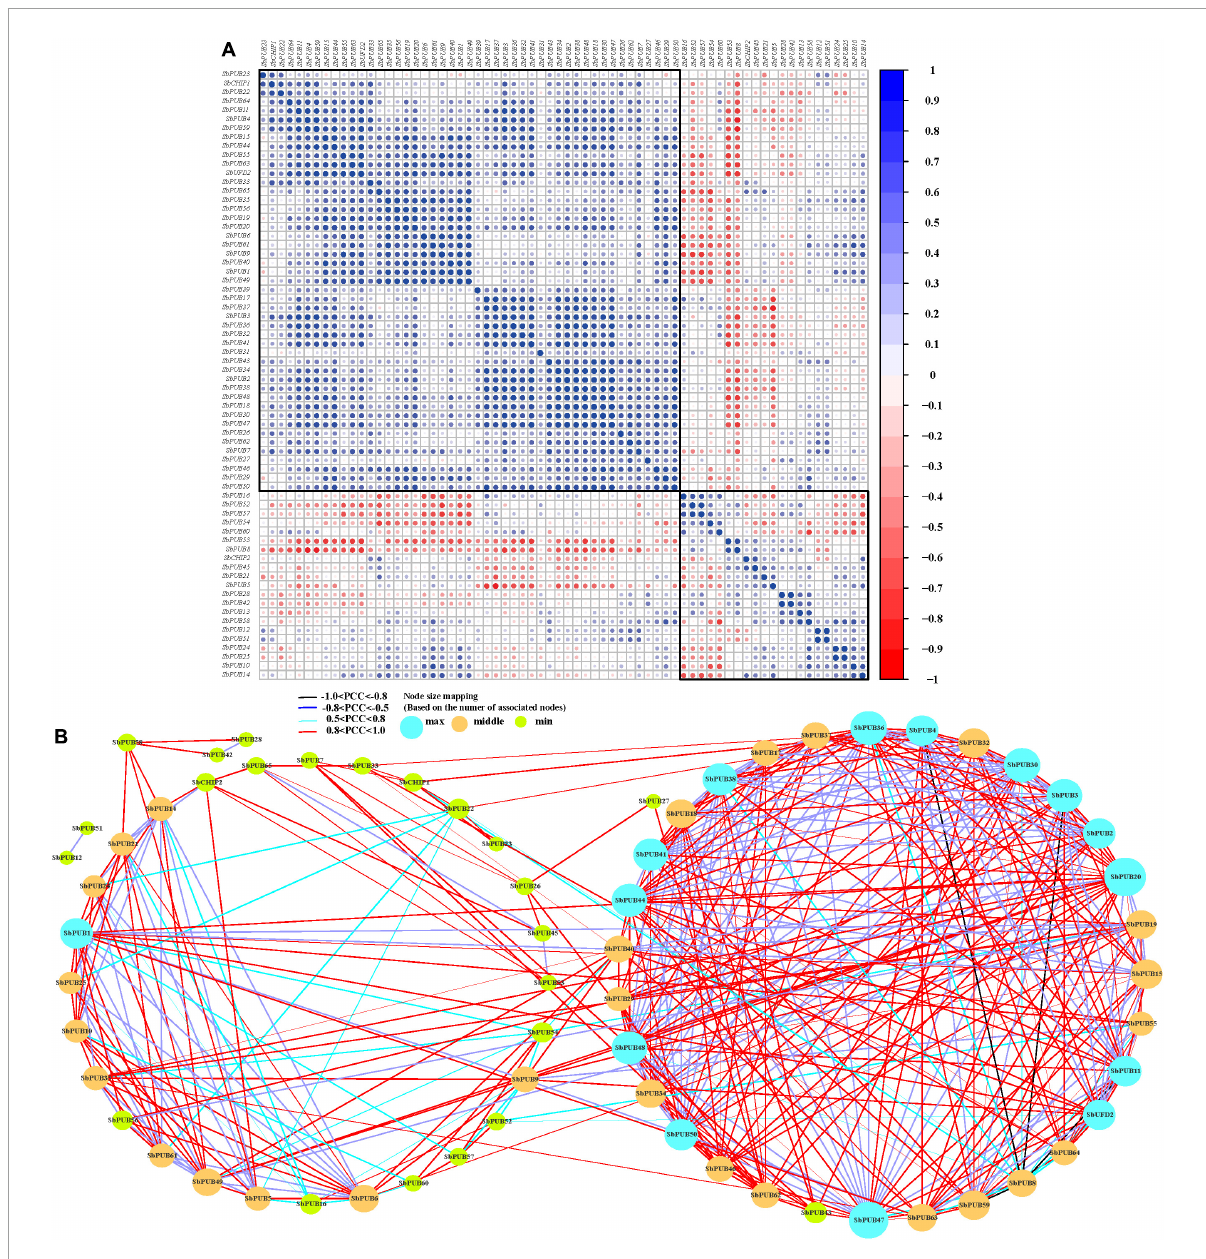
FIGURE8 Correlation and co-regulation network of sorghum U-box genes. (A) Correlation analysis of U-box genes conducted by Pearson correlation coefficients (PCCs). Correlations are represented by the size and color of the circles. Heatmap labels indicate PCC values. (B) Co-regulatory network of sorghum U-box genes generated based on gene pairs with significant PCCs ( p -value ≤ 0.05). The strength of correlations between gene pairs is marked at the bottom using different colored